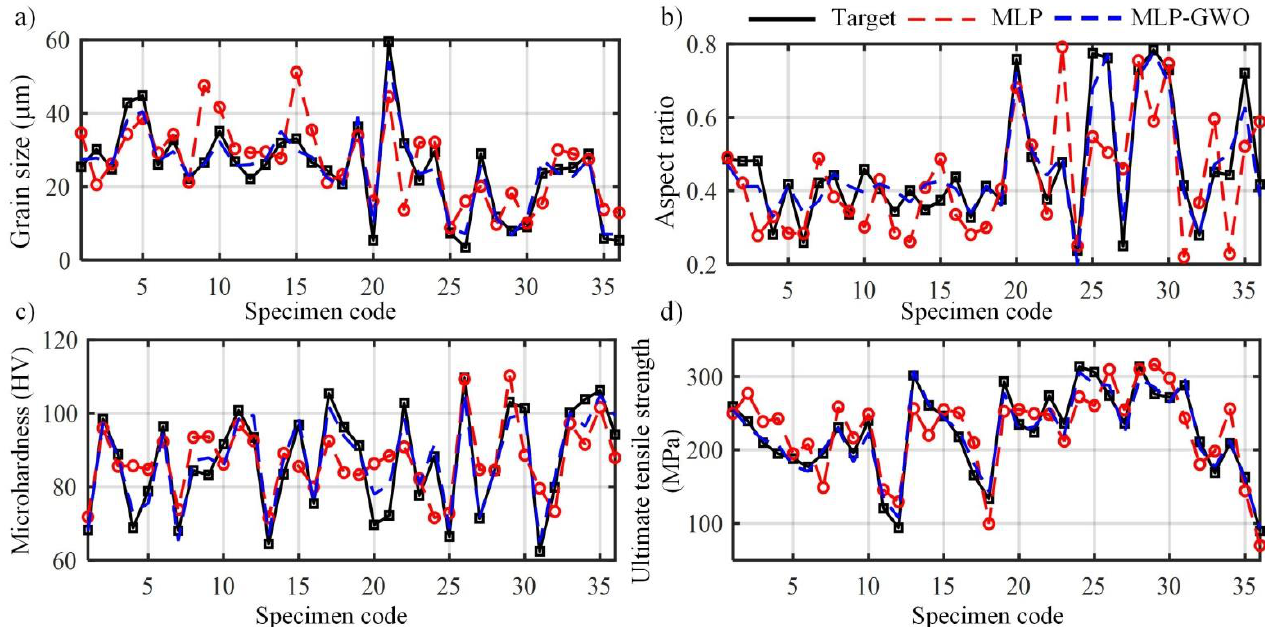
Figure 11. The measured and predicted data using MLP and MLP-GWO for: ( a ) grain size, ( b ) aspects ratio, ( c ) microhard- ness, and ( d ) ultimate tensile strength.